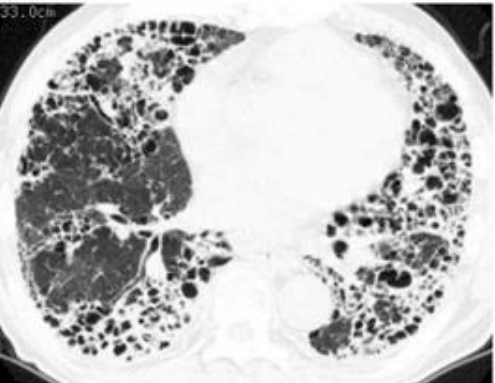
Figure 8. A case of RA-ILD in which the complication of nontuberculous mycobacterial pulmonary disease ( Mycobacterium kansasii infection) developed. Chest computed tomography showed consolidation along with honeycombing.